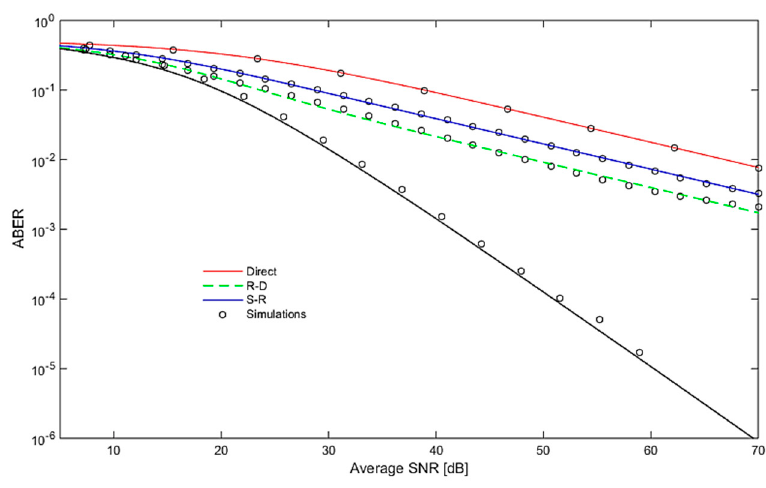
Figure 13. ABER vs. SNR of FSO over the G ‐ G channel for strong turbulence with distance 600–400 m, the number of relays = 3 and w z = 2 m.